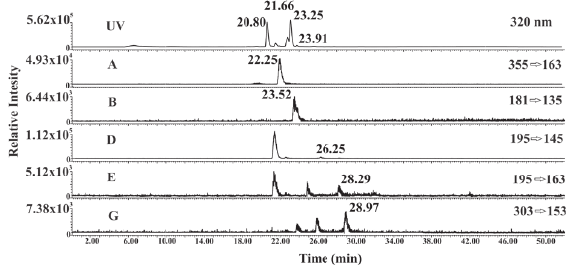
Figure 1 - Simultaneous quantifi cation of phenolic compounds. Figure 2 - Chromatogram of the lyophilized coconut water, by LC/MS/MS. Injection of 75 mg/mL solution of LCW in ACN 10% with formic acid 0.1%. The lyophilized CW was analyzed by Kinetex C18 XB (100 mm x 4.6 mm i.d., 2.6 µm of particle size, 100 Å, Phenomenex, Torrance, CA), at 20°C, injection volume of 150 µL and fl ow rate of 0.175